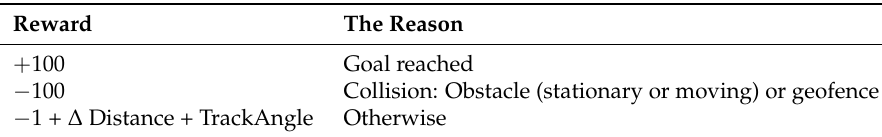
Table 2. Rewards.